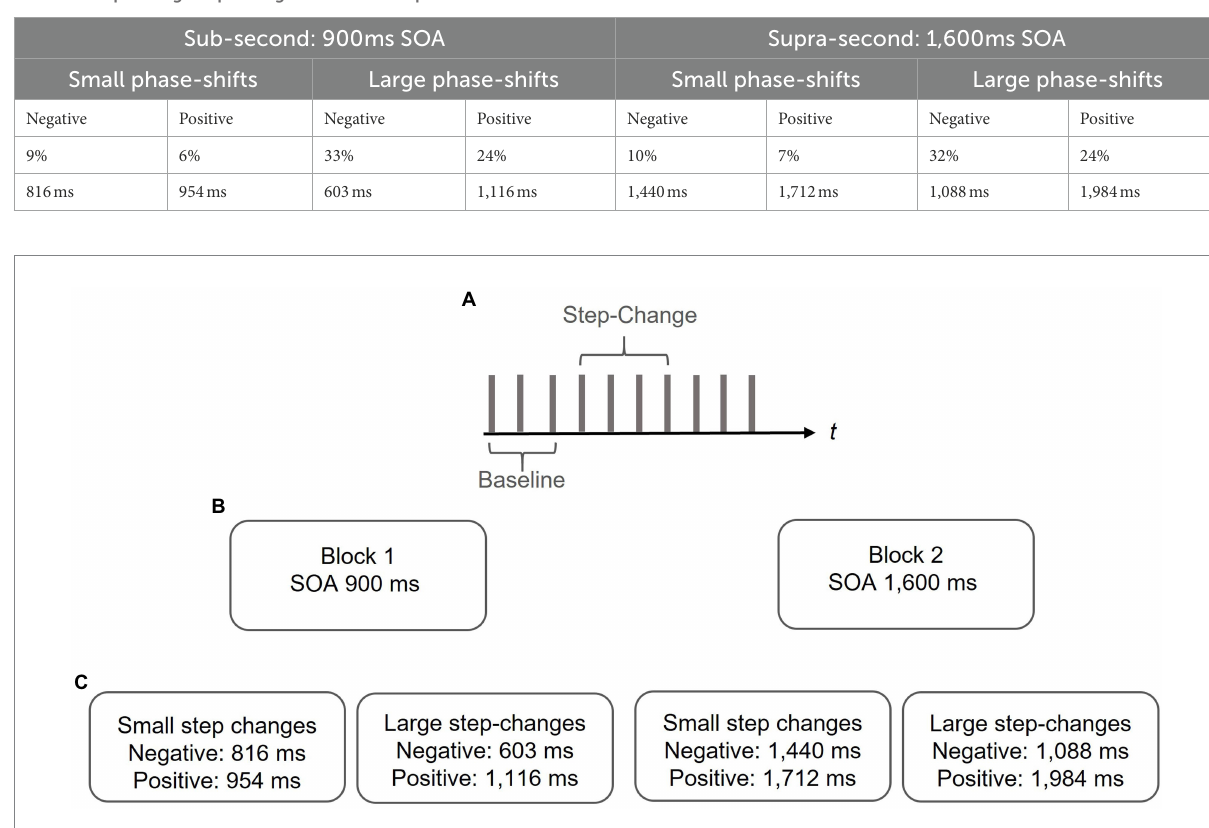
TABLE 1 Step-change depending on direction of phase-shift and base interval.